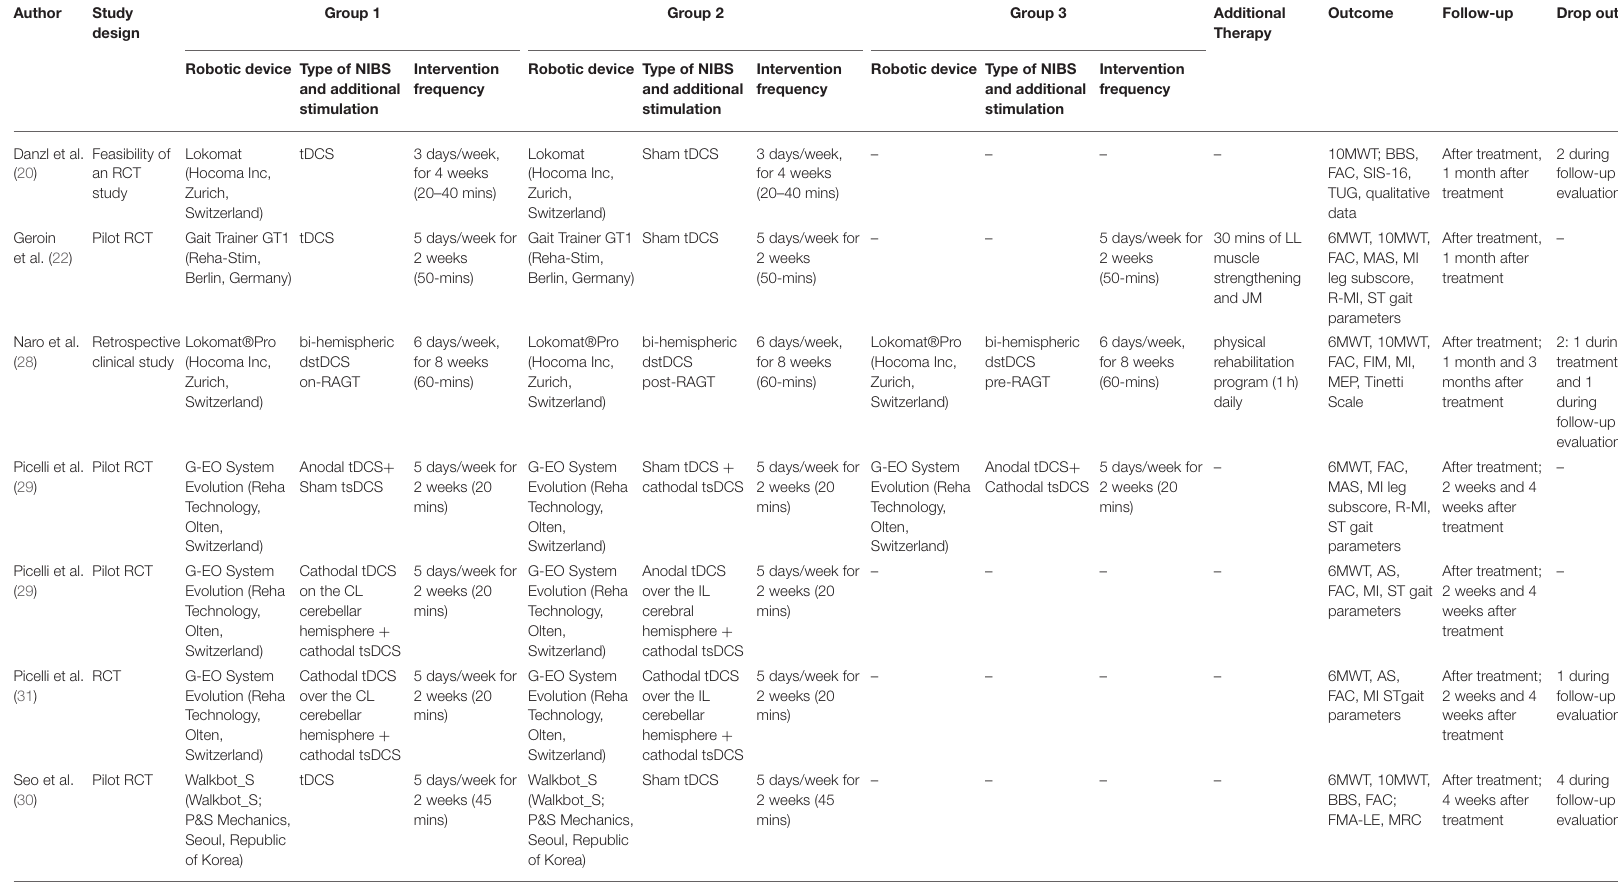
6MWT,6-minwalkingtest;10MWT,10-meterwalkingtest;AS,Ashworthscale;BBS,Bergbalancescale;CL,contralesional;FAC,functionalambulatorycategory;FIM,functionalindependencemeasure;FMA-LE,Fugl-Meyerassessment oflowerextremity;IL,ipsilesional;JM,jointmobilization;LL,lowerlimb;MAS,modifiedAshworthscale;MEP,motor-evokedpotentials;MIlegsubscore,Motricityindexlegsubscore;MRC,medicalresearchcouncilscale;RCT,randomized control trial; R-MI, rivermead motricity index; SIS-16, stroke impact scale 16; ST, spatiotemporal; tDCS, transcranial direct current stimulation; tsDCS, transpinal direct current stimulation; TUG, timed up and